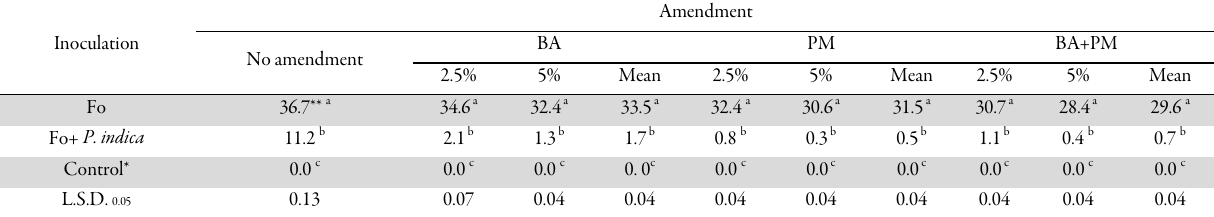
Table 7b. Effect of seed inoculation of cucumber with P. indica and soil amendment with organic wastes on disease severity of FW in the greenhouse in non-autoclaved soil Inoculation